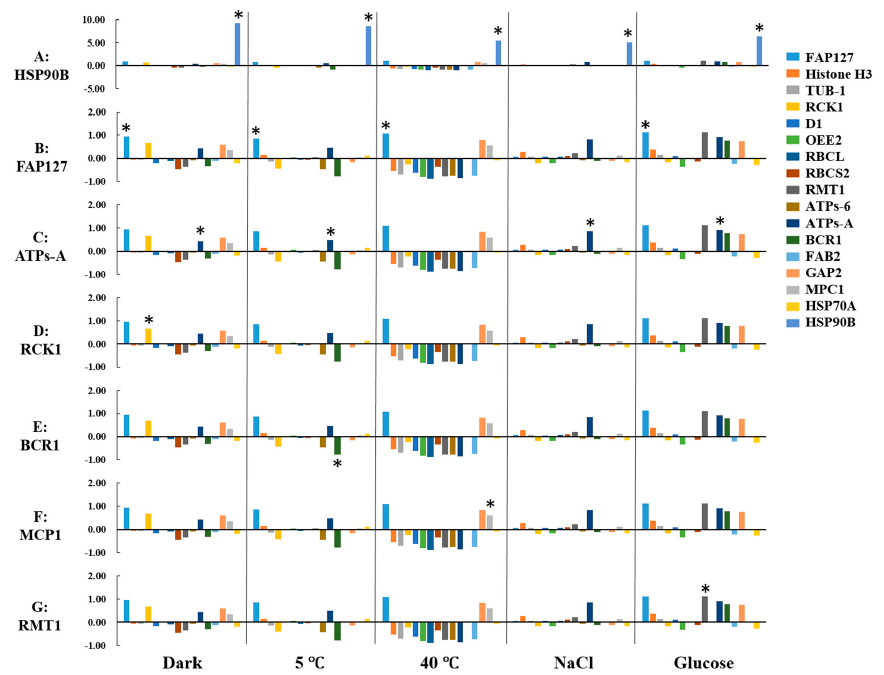
Figure 5. Average relative fold change (ARF) of candidate proteins and selected biomarkers. ARFs